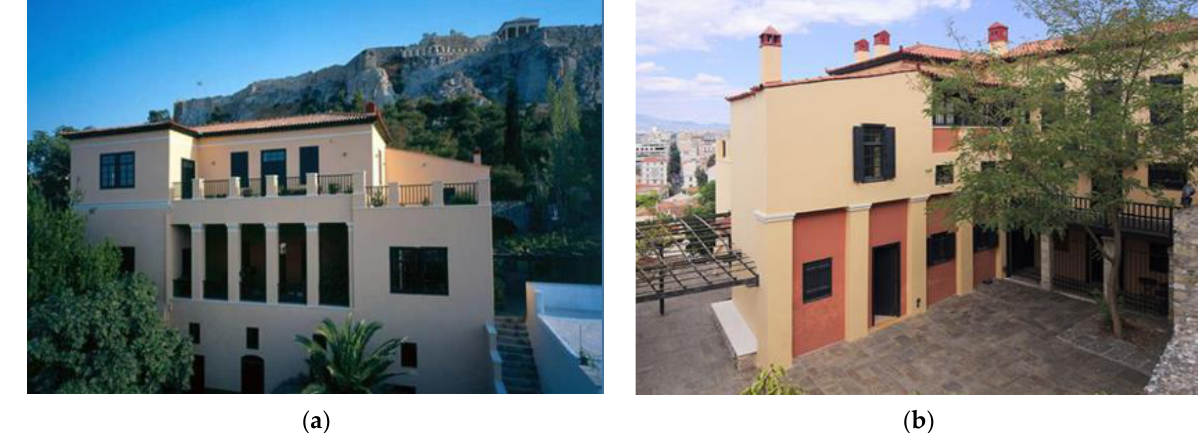
Figure 1. ( a ) Façade and ( b ) backyard of the Athens University Museum, Cleanthis-Schaubert Residence.